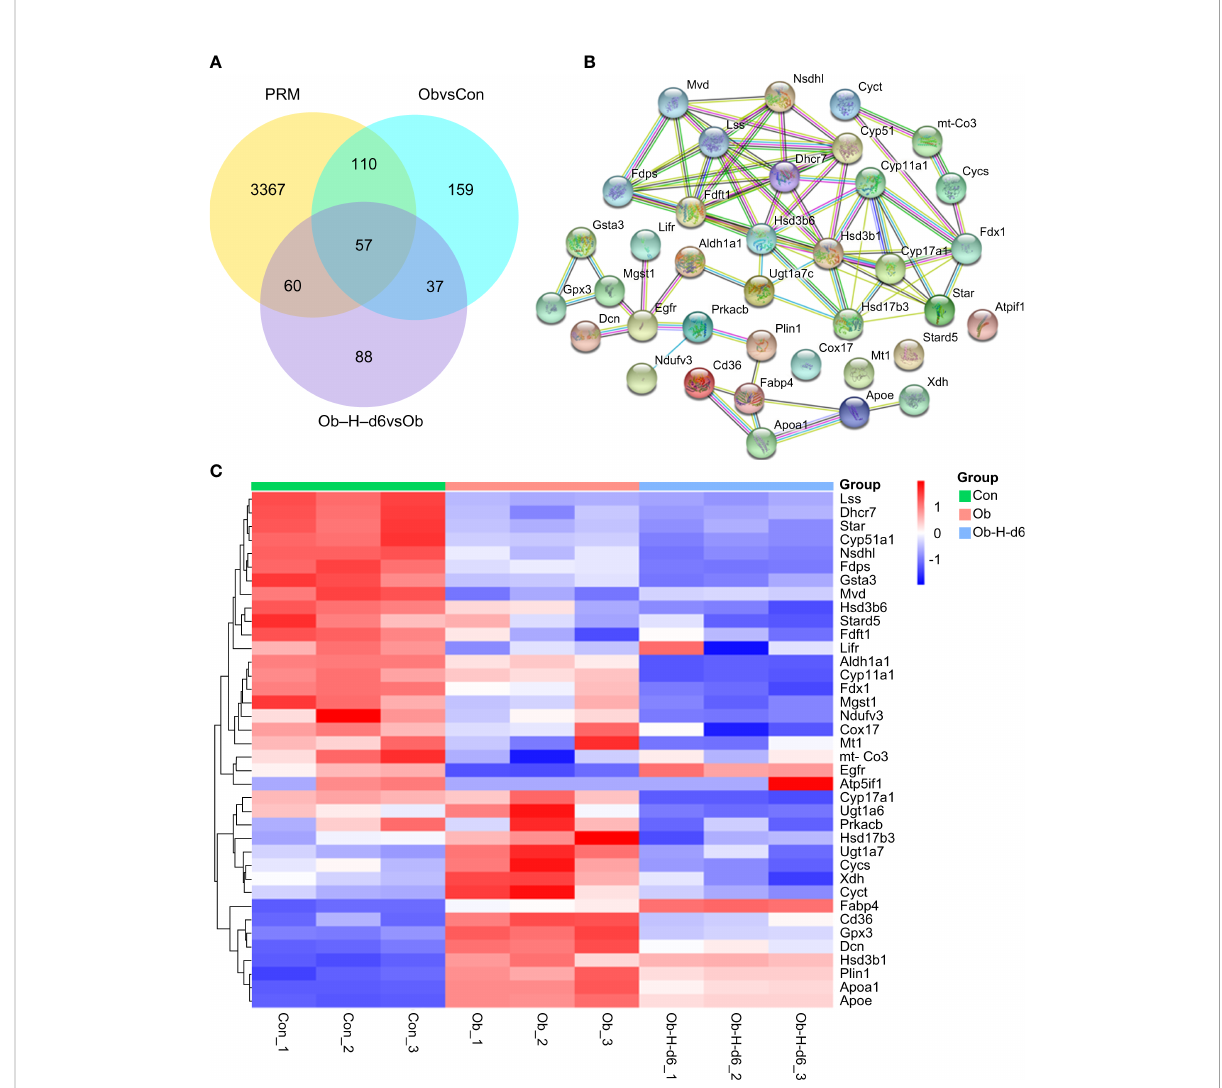
FIGURE 9 (A) Number of DEPs that could be accurately quantitated by PRM in the Ob/Con and Ob-H-d6/Ob comparison groups. (B) PPI network analysis using the STRING database for 38 DEPs likely related to testosterone production. (C) Heatmap analysis for the 38 representative DEPs. Con, Control group; Ob, Obese group; Ob-H, Obese-Hypoxia